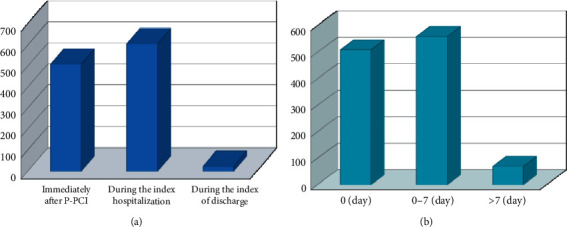
The time of the second sample taken after primary PCI. There were 509 (44.728%) cases measured immediately after PPCI and 606 (53.251%) measured during the index hospitalization. Five hundred and nine (44.728%) cases were measured at the same day of primary PCI and the cases measured during 0–7 days were 560 (49.209%).